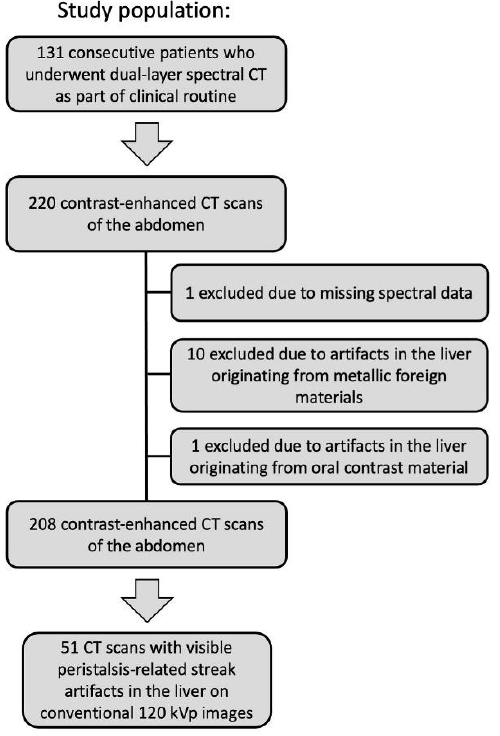
Figure 1. Flow diagram of the study population. CT (Computed